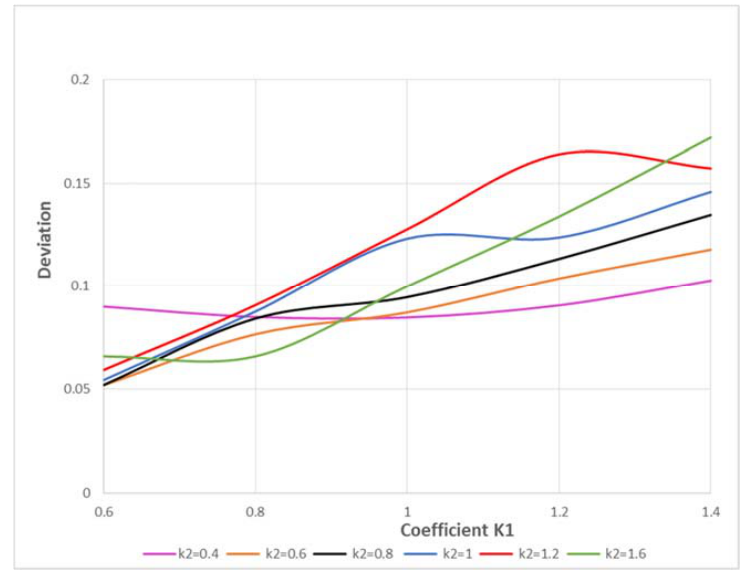
Figure 2. Deviation for the different constant values of the coefficient k 2 .